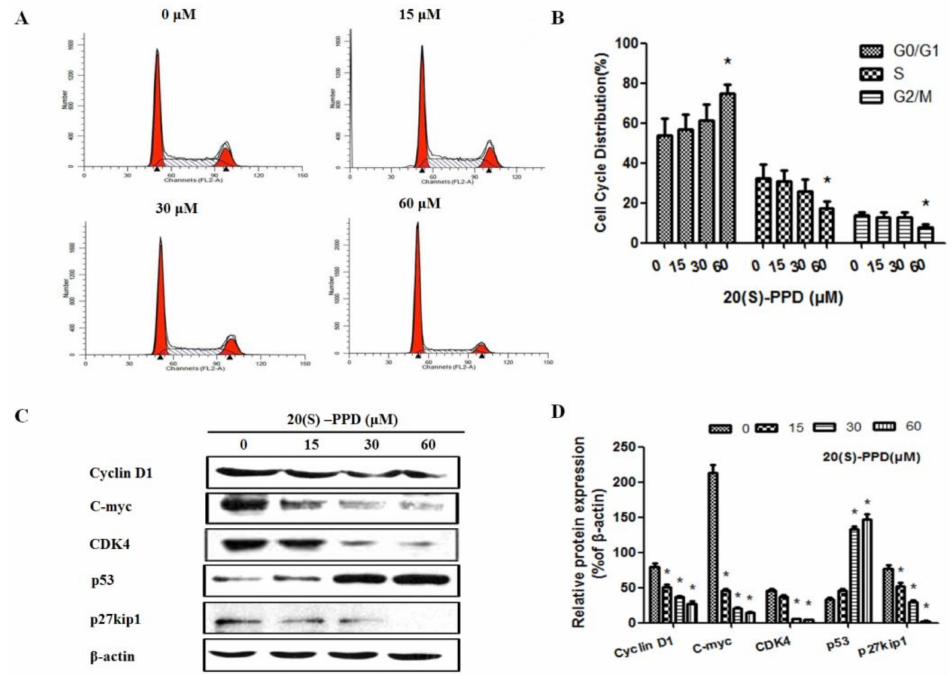
Figure 3. Effects of 20(S)-PPD on cell cycle arrest and the arrest-related proteins in MCF-7 cells. ( A , B ) Flow cytometry was used to detect cell cycle distribution. After 24 h treatment with 20(S)-PPD (0, 15, 30, and 60 µ M), a propidium iodide (PI) staining assay was performed on MCF-7 cells. ( C , D ) In MCF-7 cells treated with 20(S)-PPD, the expression of cell cycle arrest-related proteins p53, p27 kip1 , c-myc, CDK 4, and cyclin D1 was detected by Western blot. G0 phase is a resting phase where the cell has left the cycle and has stopped dividing. G1 Phase is the first phase within interphase, from the end of the previous M phase until the beginning of DNA synthesis. S phase starts when DNA synthesis commences, when it is complete, all of the chromosomes have been replicated. G2 phase occurs after DNA replication and is a period of protein synthesis and rapid cell growth to prepare the cell for mitosis. M phase is called chromosome separation phase. All data were represented as mean ±